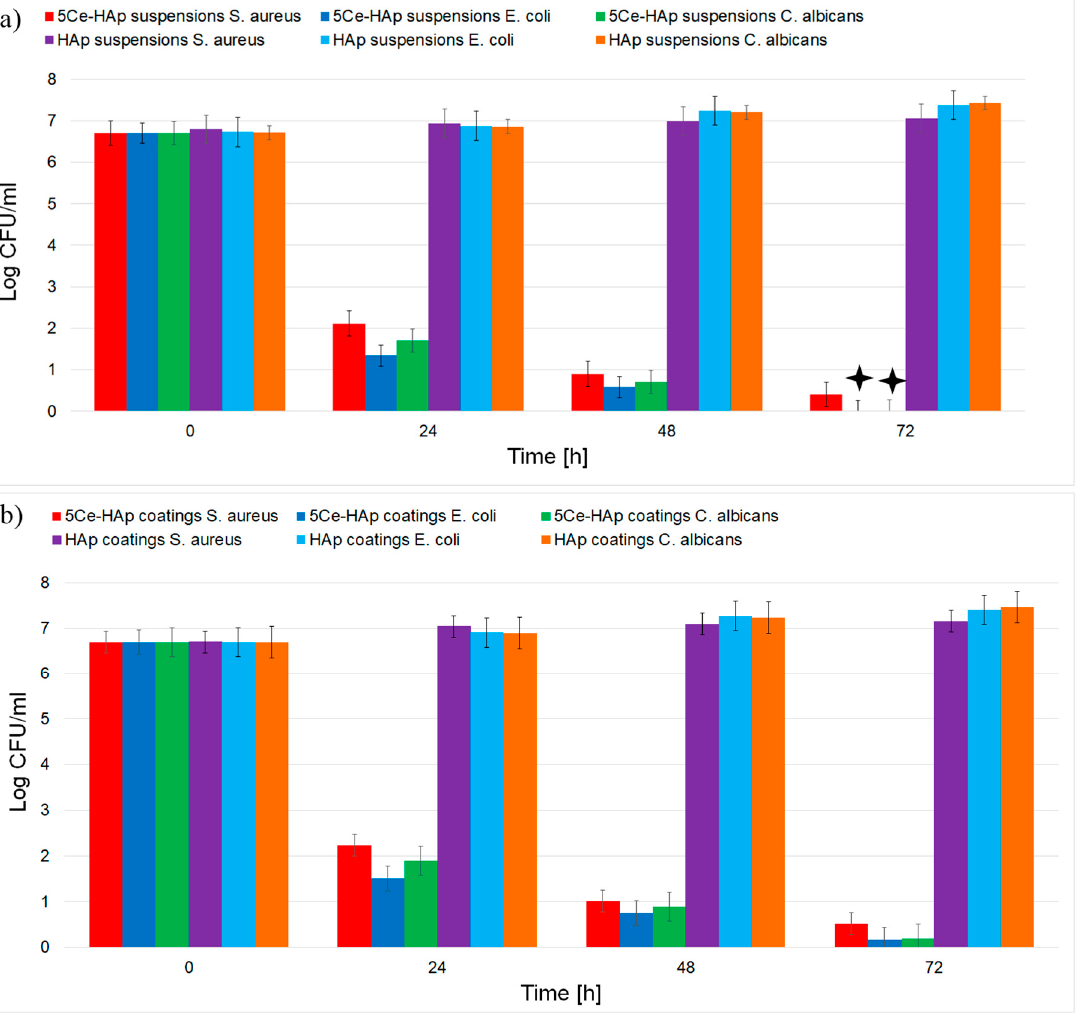
Figure 10. The graphical representation of the Log colony forming units (CFU)/mL as a function of time of exposure to the HAp and 5Ce–HAp suspensions ( a ) and HAp and 5Ce–HAp coatings ( b